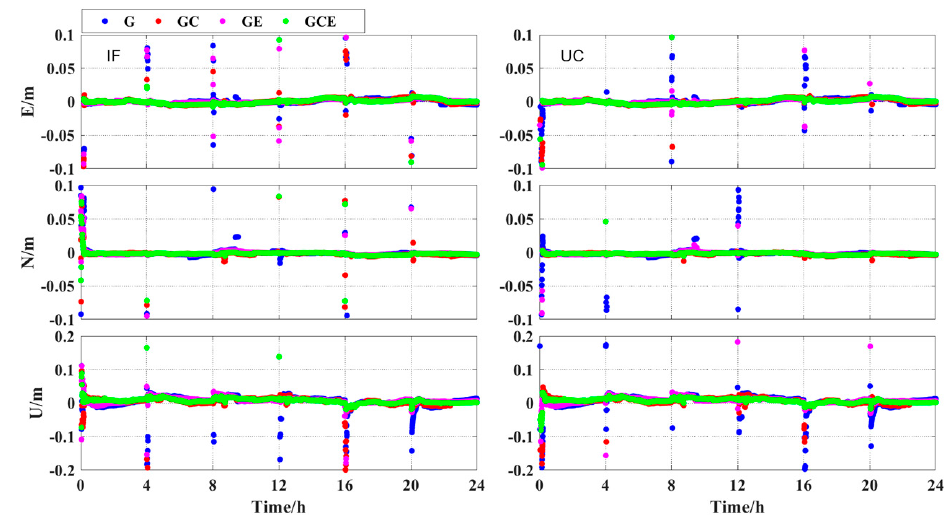
Figure 10. The RMS results of position differences of the IF model ( left ) and UDUC model ( right ) G/GE/GC/GCE static PPP-AR on DOY 301, 2021, for the YEL2 station.